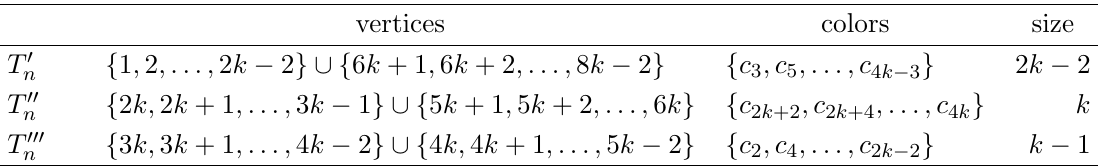
when n = 8 k + 2 and T (cid:48)(cid:48)(cid:48) , T (cid:48)(cid:48) Table 2: Features of T (cid:48) n n n vertices colors